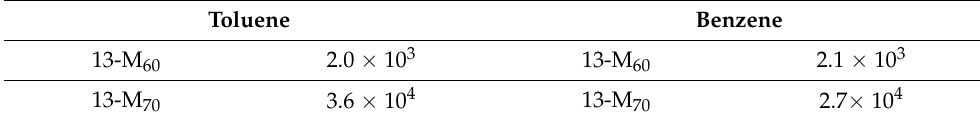
Figure 3. 1 H-NMR titration curve of receptor 17 with the C 70 fullerene in toluene (298 K, 300 MHz) ( a ) and structure of the 1:1 17-C 70 complex ( b ) [36]. Table 4. Stability constants, K a [M − 1 ], ofthe 17 - C 60 and 17-C 70 complexes at 25 ◦ C